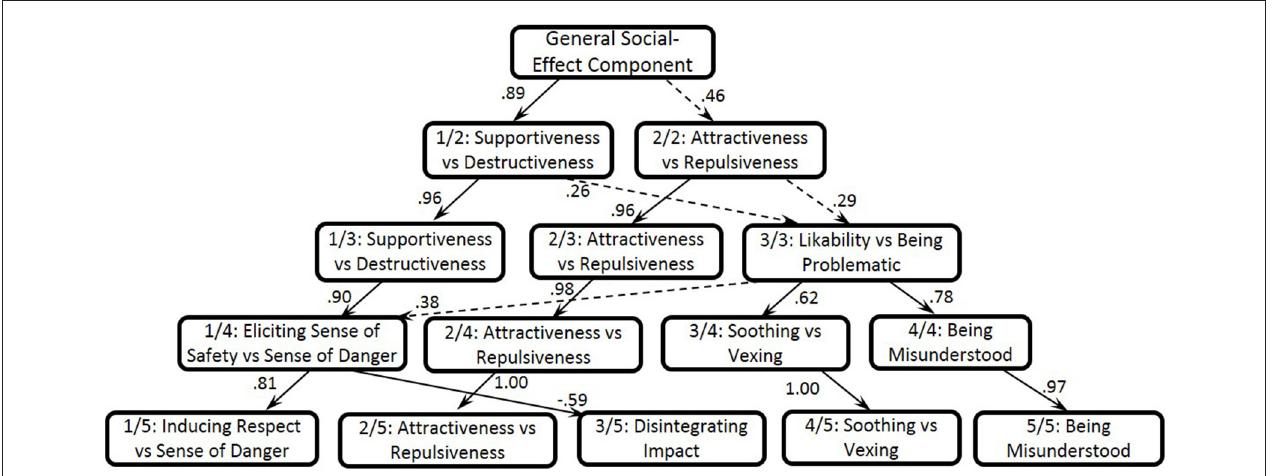
FIGURE 2 | One to five-component hierarchical structure of the social effects based on the self-rating data.